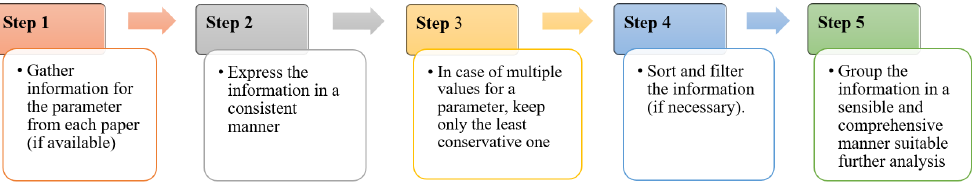
Figure 3. Parameter analysis process.